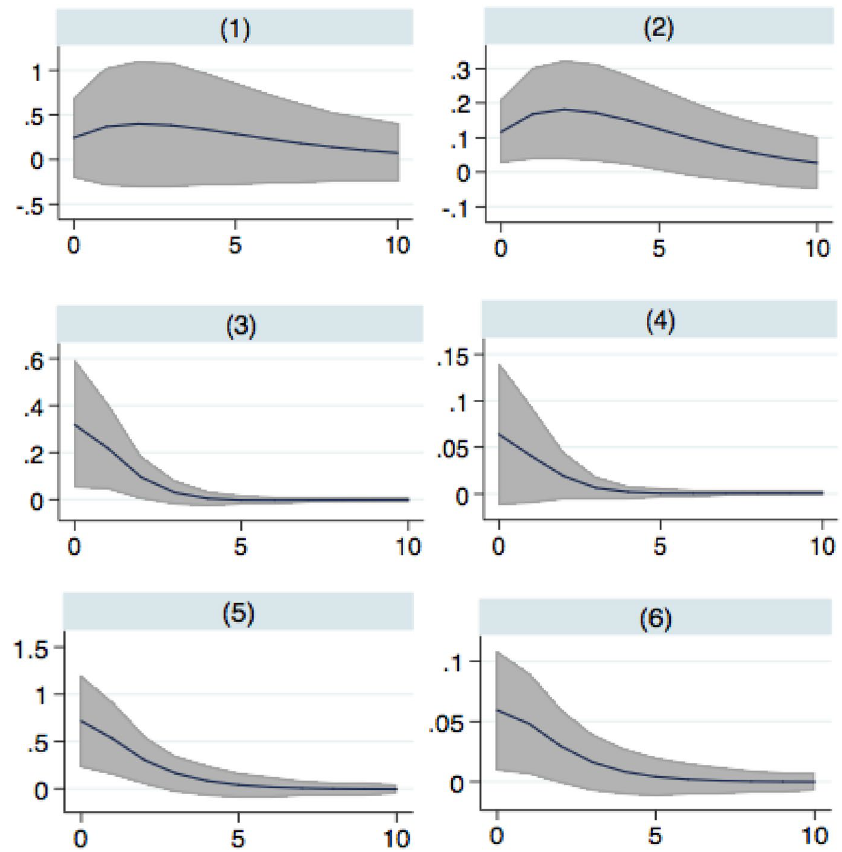
Fig. 3 Dynamic multipliers of the effect of credibility shock on business cycle synchronization. Source : Own